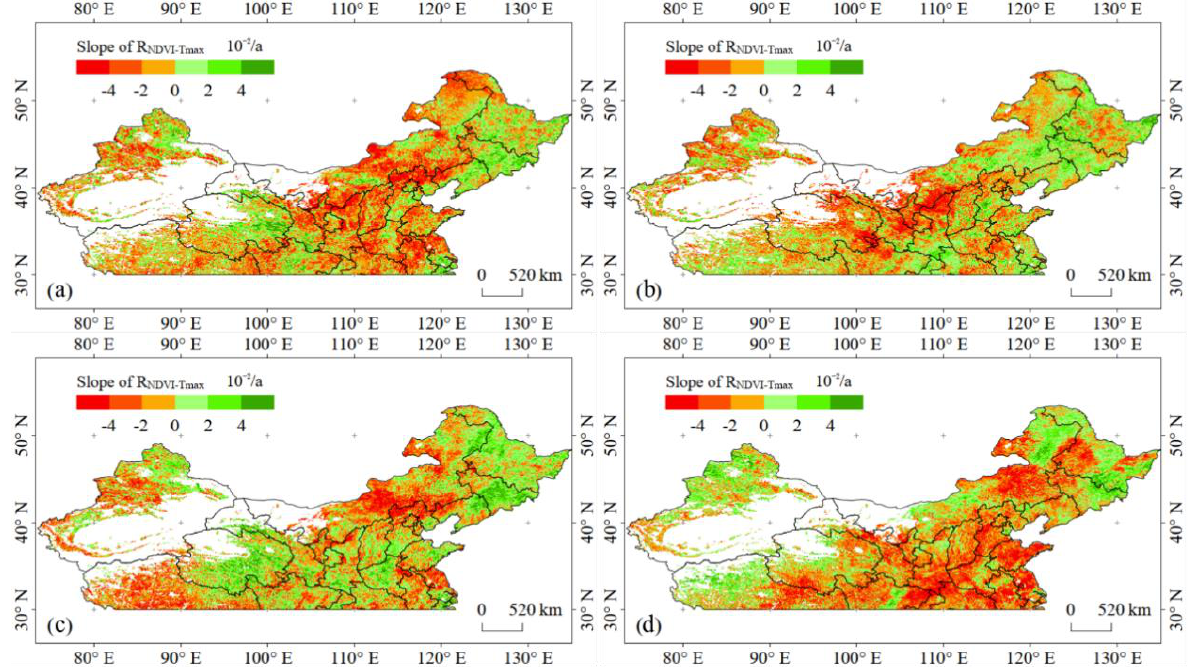
Figure 4. Spatial distribution of the trend of partial correlation coefficient between NDVI and daytime temperature (R NDVI−Tmax ) during 1982–2015 for growing season ( a ), spring ( b ), summer ( c ) and autumn ( d ).